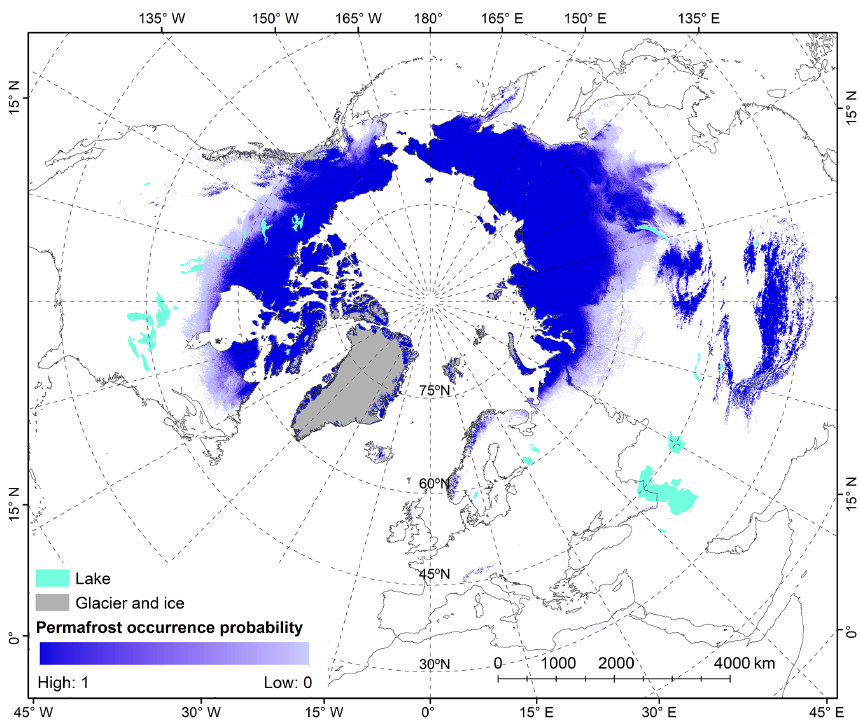
Figure 6. The present-day probability of permafrost occurrence in the Northern Hemisphere for the period of 2000–2016 (the probability is defined by the fraction of predicted MAGT ≤ 0 ◦ C based on the multimodel ensemble results with 1000 runs).